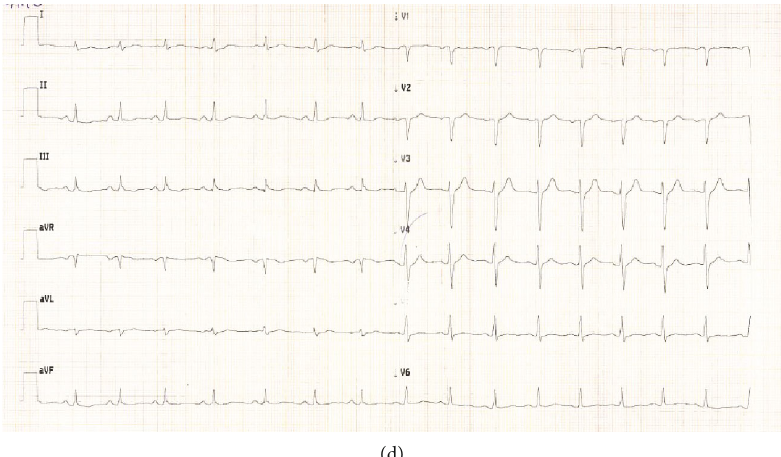
Figure 1: (a) ECG in the emergency department. (b) ECG at the admission to the ICU. (c) ECG taken 12 h after pPCI. (d) ECG taken 4 months after